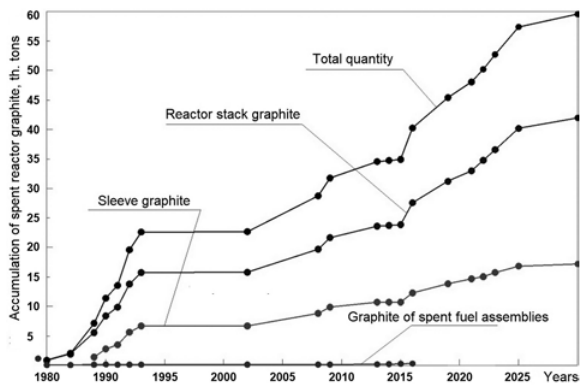
Figure 2. Forecasted dynamics of collecting radioactive graphite waste in Russia. Reproduced from [7] with